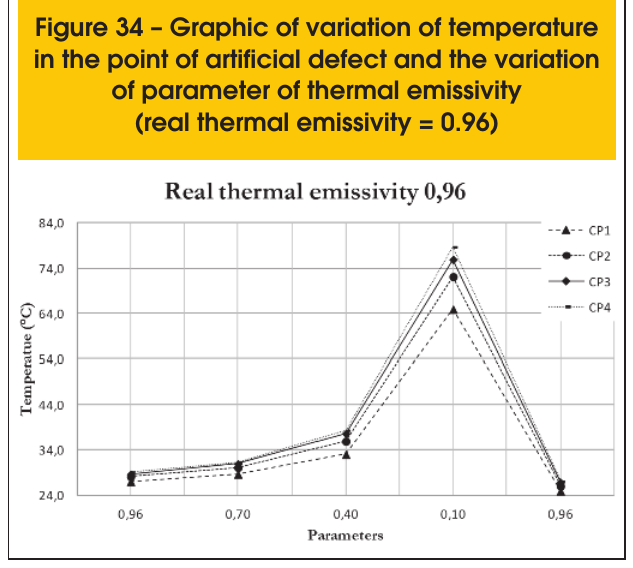
Figure 32 – Graphic of variation of temperature in the point of artificial defect and the variation of parameter “relative air humidity”